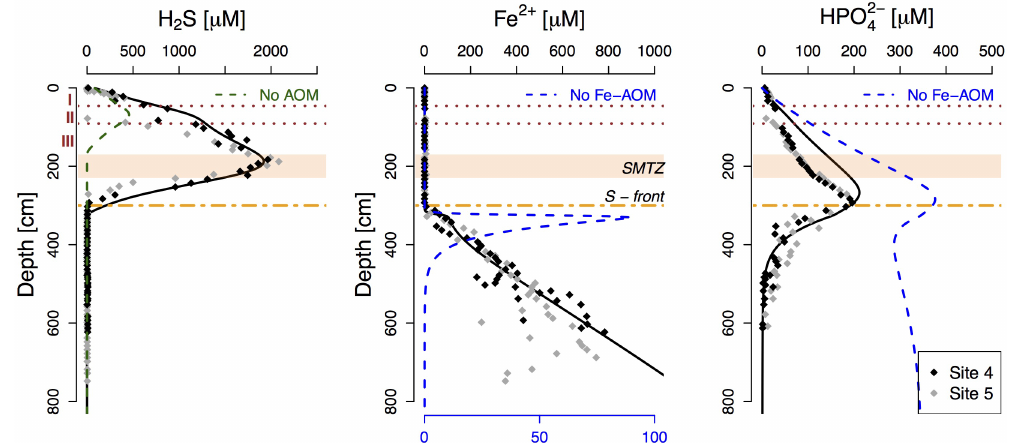
Figure 8. Porewater profiles of dissolved sulfide, Fe 2 + and HPO 2 − . The green dashed line represents the modeled sulfide profile without 4 SO 4 -AOM, indicating that the latter significantly enhances the downward sulfidization. Blue dashed lines denote the modeled Fe 2 + and HPO 2 − profiles without ongoing Fe oxide reduction in the limnic deposits (i.e., no Fe-AOM). Note that concentrations of Fe 2 + were 4 multiplied 10 times in the model simulation without Fe oxide reduction to better visualize the potential release of Fe 2 + through a cryptic S cycle (corresponding x axis at bottom). Red dotted lines and roman numbers indicate the transitions between the lithological Unit I (modern coccolith ooze), Unit II (marine sapropel) and Unit III (limnic deposits). The orange bar represents the sulfate-methane transition zone (SMTZ), and the orange dashed line shows the current position of the downward-migrating sulfidization front (S